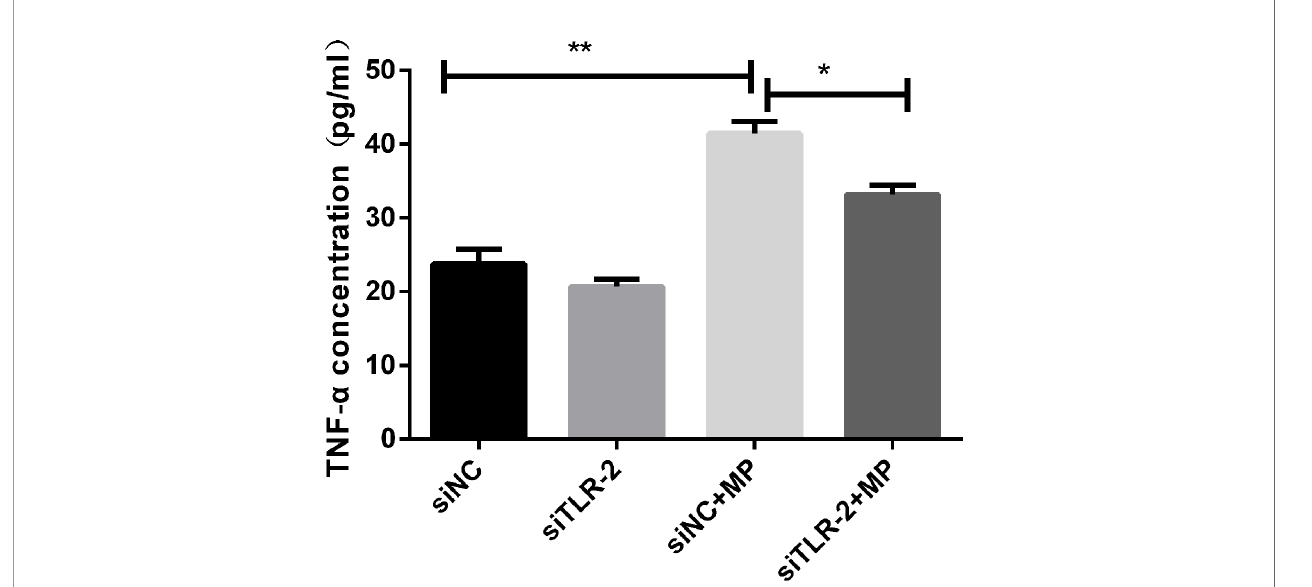
FIGURE 3 | TNF- a secretion measured by ELISA in control or MP-infected A549 cells with or without knockdown of TLR2 by siRNA. **P < 0.01 , *P < 0.05. P < 0.05 is statistically signi fi cant. siNC = A549 cells were transfected with negative control small interfering RNA (siRNA); siTLR-2 = A549 cells were transfected with siRNA targeting TLR2. MP, Mycoplasma pneumoniae